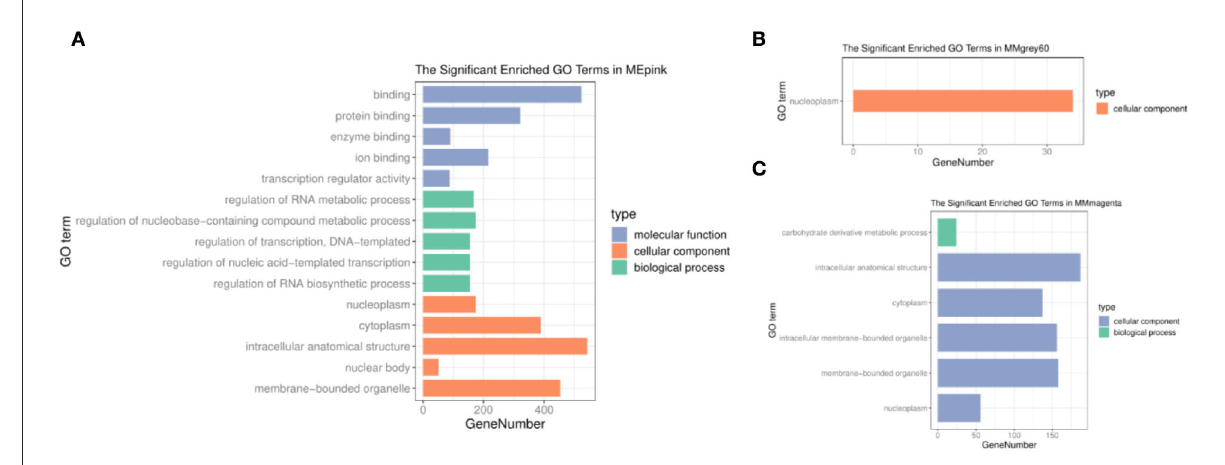
FIGURE3 GO enrichment analysis. (A) Pink module. (B) Grey60 module. (C) Magenta module.